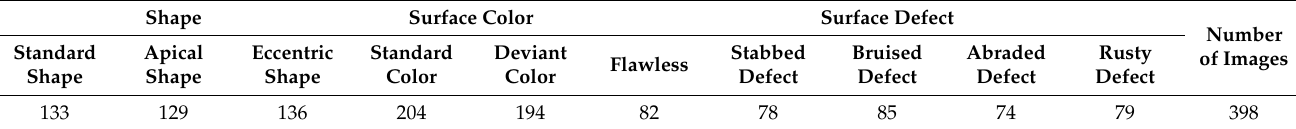
Table 3. The number of samples in the corresponding categories of grading indicators.